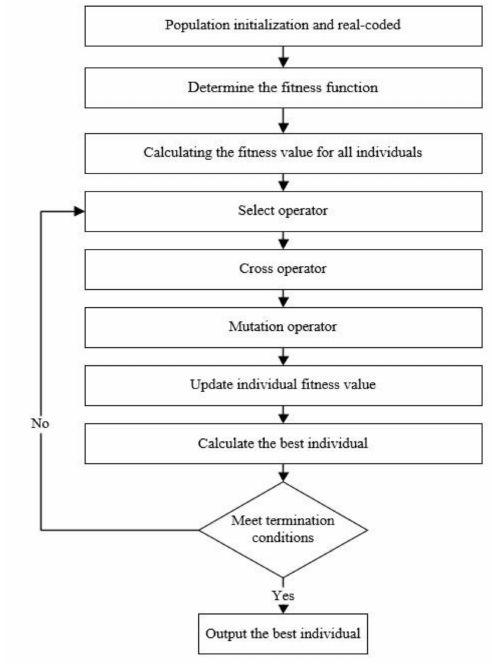
Figure 6. Flow chart of Genetic Algorithm